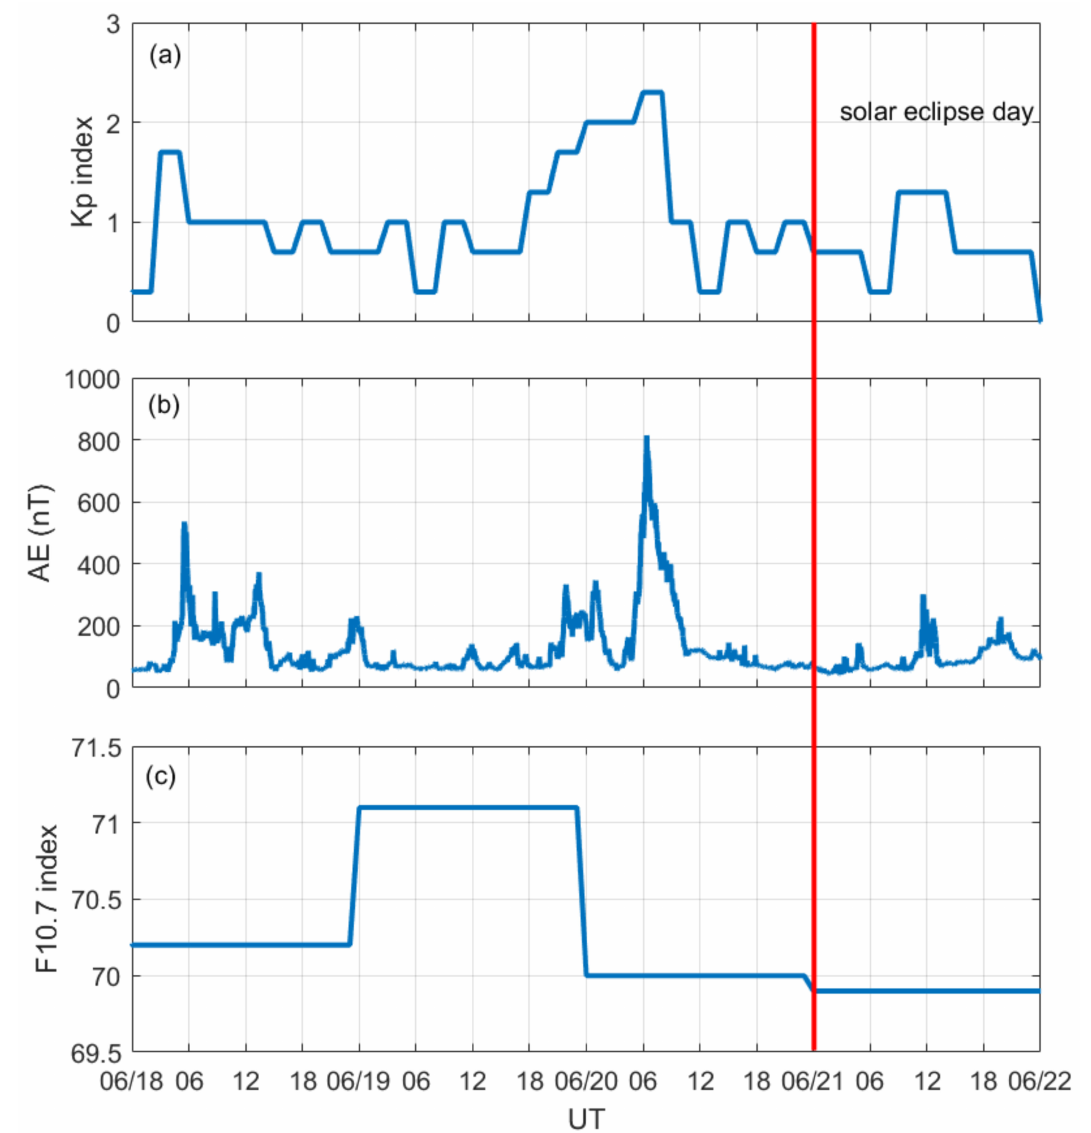
Figure 1. Geomagnetic and solar condition on the 21 June 2020 solar eclipse and three days before. ( a ) Kp, ( b ) Auroral Electrojet (AE) and ( c ) F10.7